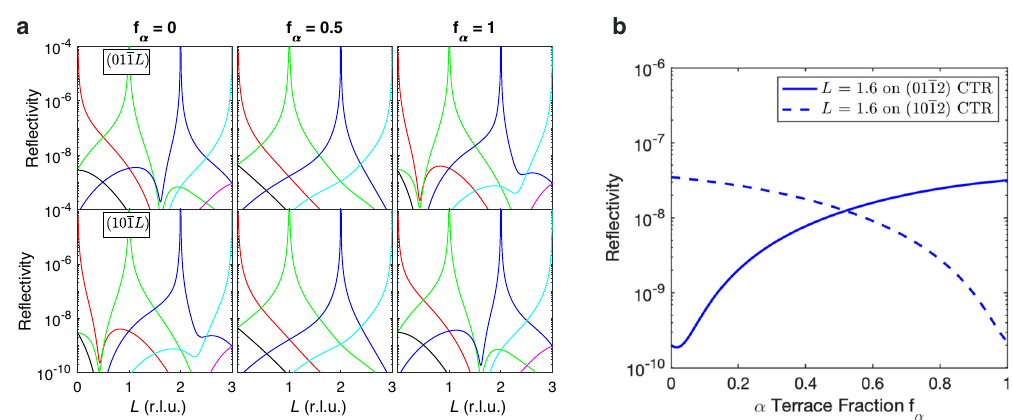
Fig. 3 Calculated CTR intensities for a vicinal GaN (0001) surface. a Top and bottom rows show the families of CTRs along ð 011 L Þ and ð 101 L Þ , respectively. Black, red, green, blue, cyan, and magenta curves are for CTRs from the L 0 = − 1 to 4 Bragg peaks, respectively. Values of f α for each column are given at the top. b Re fl ectivity of selected CTRs as a function of terrace fraction f α for fi xed values of L = 1.6.